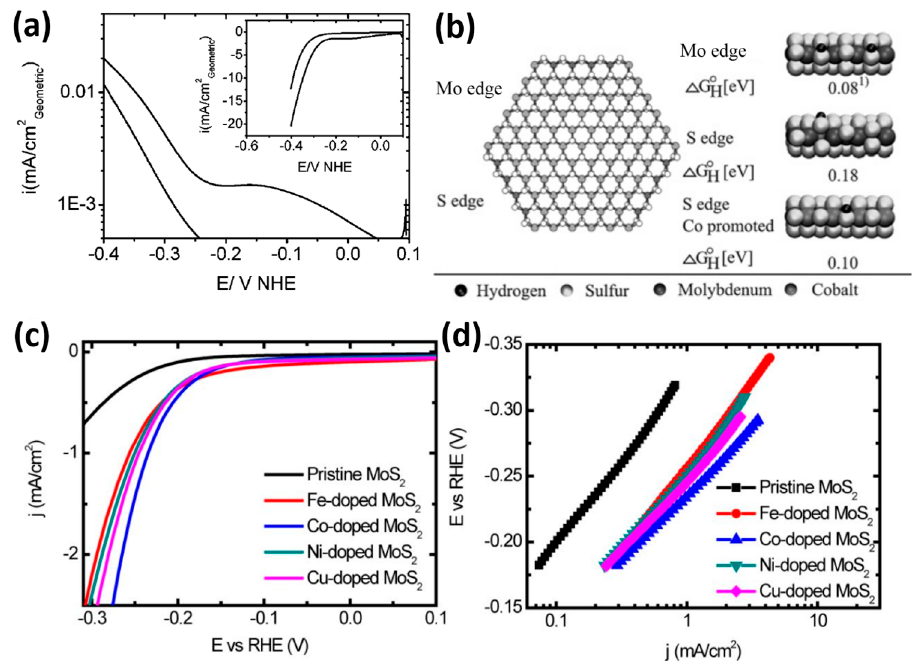
Figure 2. ( a ) Tafel plots and polarization curves (inset) of the HER on MoS 2 and cobalt-doped MoS 2 [36]; ( b ) Left: molecular model of a hexagon MoS 2 exposing both the S edge and the Mo edge. Right: differential free energies of hydrogen adsorption [36]; ( c ) Polarization curves and ( d ) Tafel plots of the pristine and transition metal doped MoS 2 nanofilms [43]. Reproduced from [36] with permission from copyright 2008 The Royal Society of Chemistry and [43] with permission from Springer.